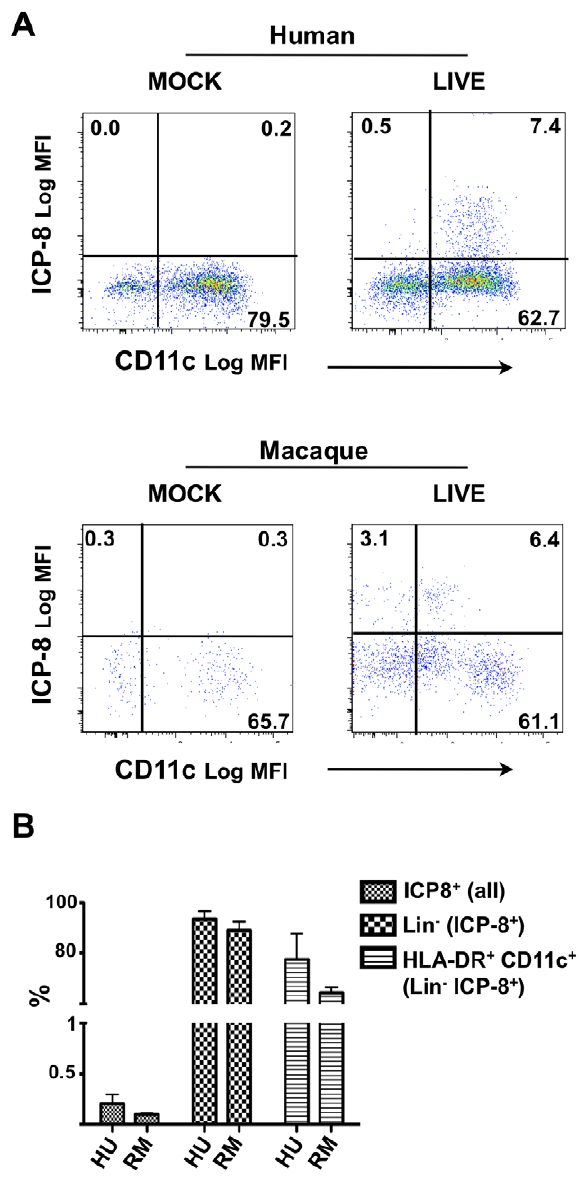
Figure 2. Blood CD11c + DCs are susceptible to HSV-2 infection. A) Human (n=3) and macaque (n=3) PBMCs were HSV-2- infected (5 MOI, LIVE) or mock-treated and the ICP-8 expression measured 24 h later. ICP-8 versus CD11c expression is shown for Lin 2 HLA-DR + cells on representative examples. The percentages of the positively stained cells are provided. B) The percentages (mean 6 SEM of 3 donors each) of total live PBMCs that are ICP8 + , of ICP8 + cells that are Lin 2 , and of the ICP8 + Lin 2 cells that are HLA-DR + CD11c + are shown for human (HU) and macaque (RM) cultures.